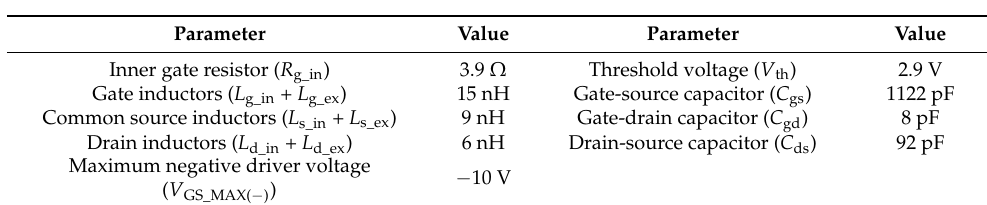
Table 1. Parameters of C2M0080120D.